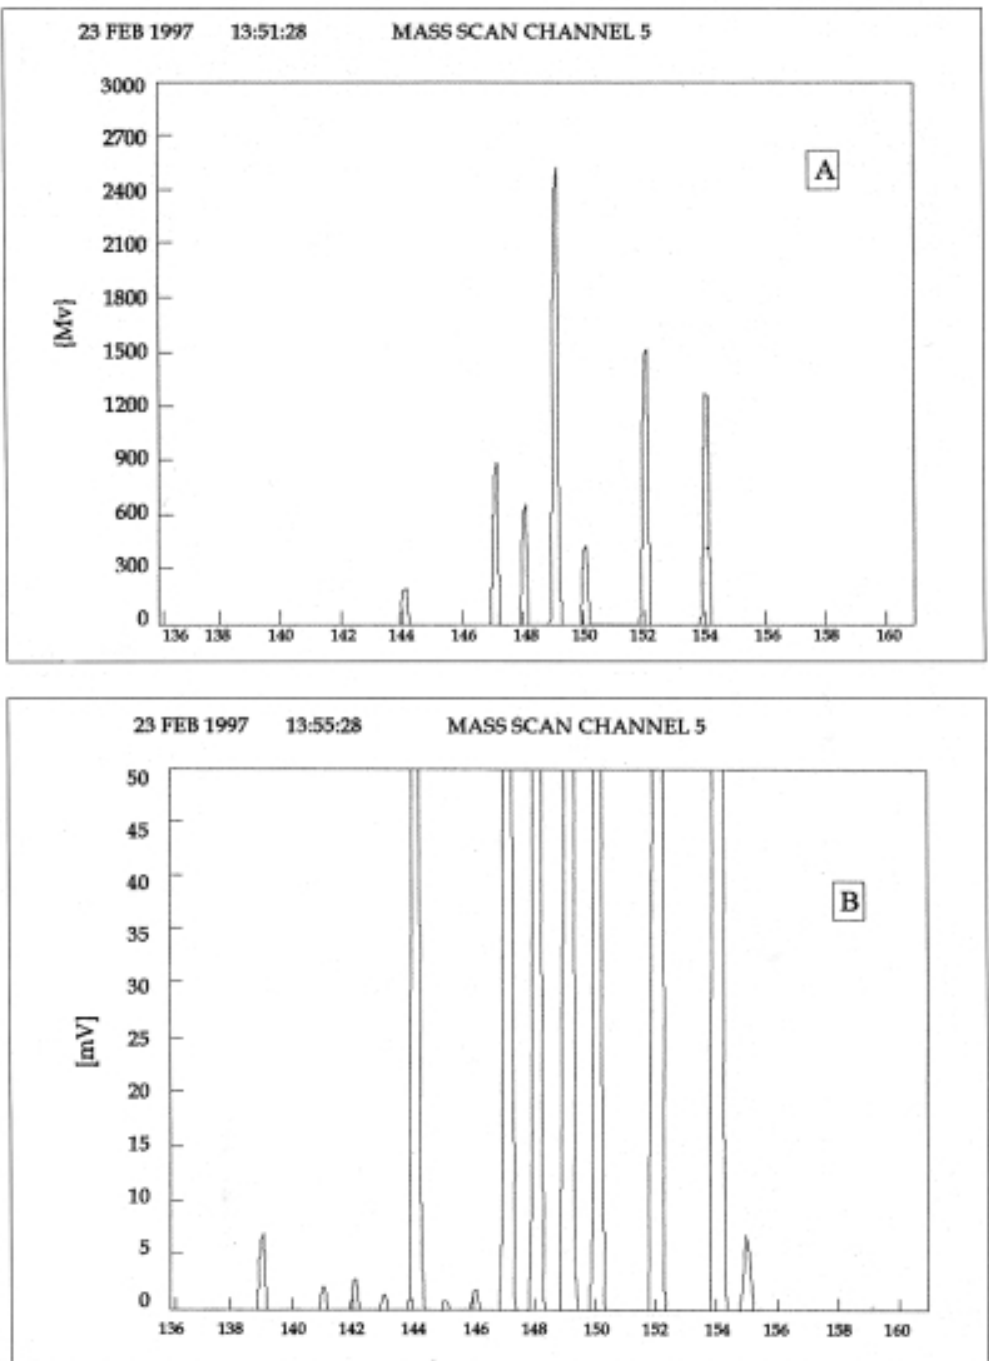
Fig. 7 – Mass interference for Sm. A – increased scale, B – with 2.6 volts for 149 Sm.